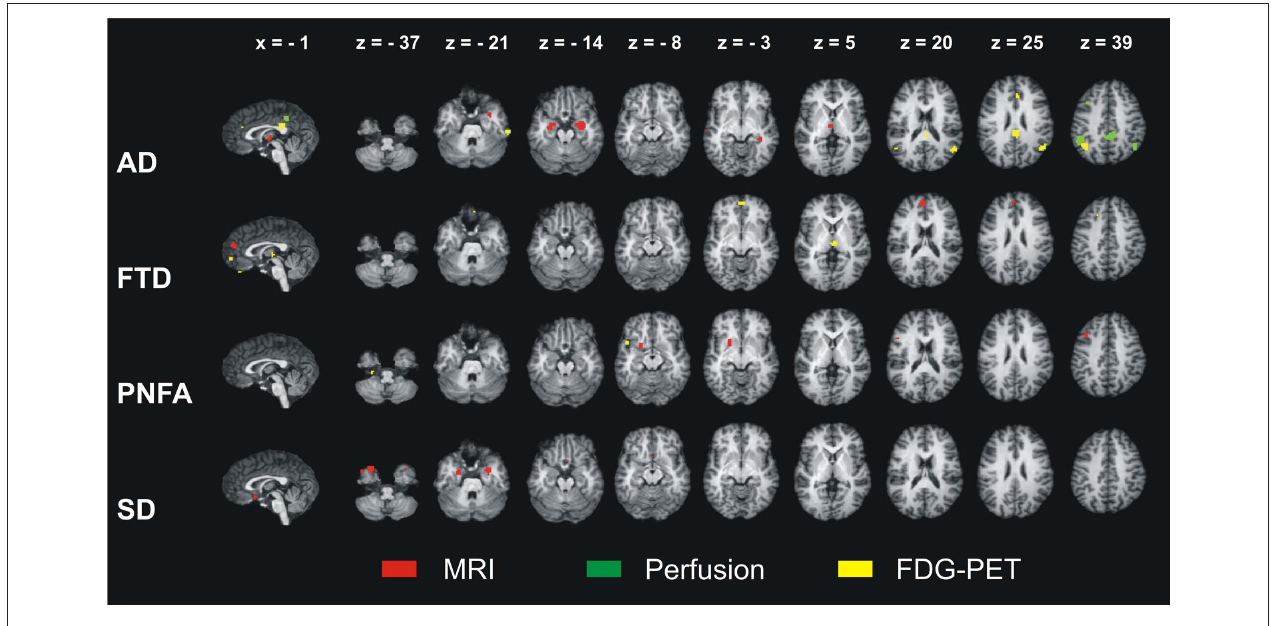
utilization as measured by 18 F-fluorodeoxyglucose-positron emission tomography (FDG-PET) in patients compared with control subjects. For AD, reductions in perfusion are additionally shown (no studies available for FTD, PNFA, and SD). ALE – anatomical likelihood estimates. Coordinates in Talairach space. Left is